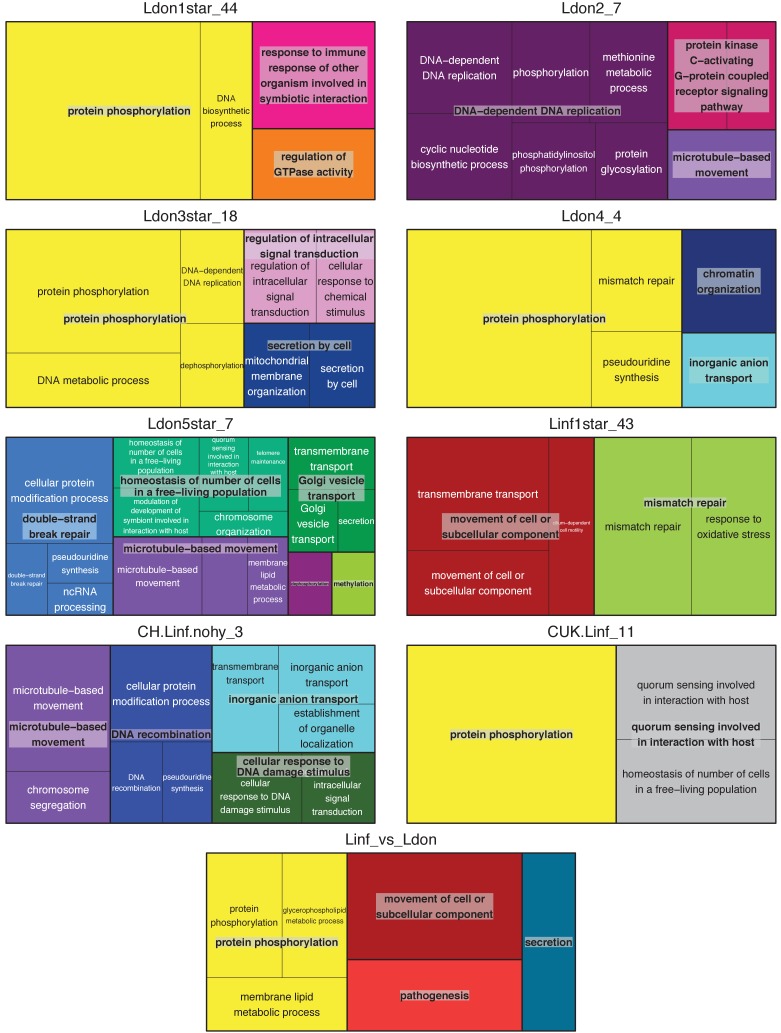
Gene ontology enrichment of marker genes with putative biological impact.For each group our species-specific GO enrichment, biological process results are shown for genes with at least one moderate or high effect variant according to SNPeff annotation (Supplementary file 3). Plots show enrichment for the lenient cut-off of a p-value<0.05 using the weighted Fisher test statistic (weightFish, topGO, Alexa et al., 2006) using Revigo (Supek et al., 2011). Sizes of rectangles are normalised by absolute log10 p-value. Plot titles indicate the group marker sets or the species comparison, respectively. Stars in the group names indicate that samples that have previously been identified as mixtures of clones have been removed (Table 1 B3 and B4). Additionally, hybrids between the major groups (Table 1 B2) were removed from this analysis. Group sample sizes are indicated at the end of each name.